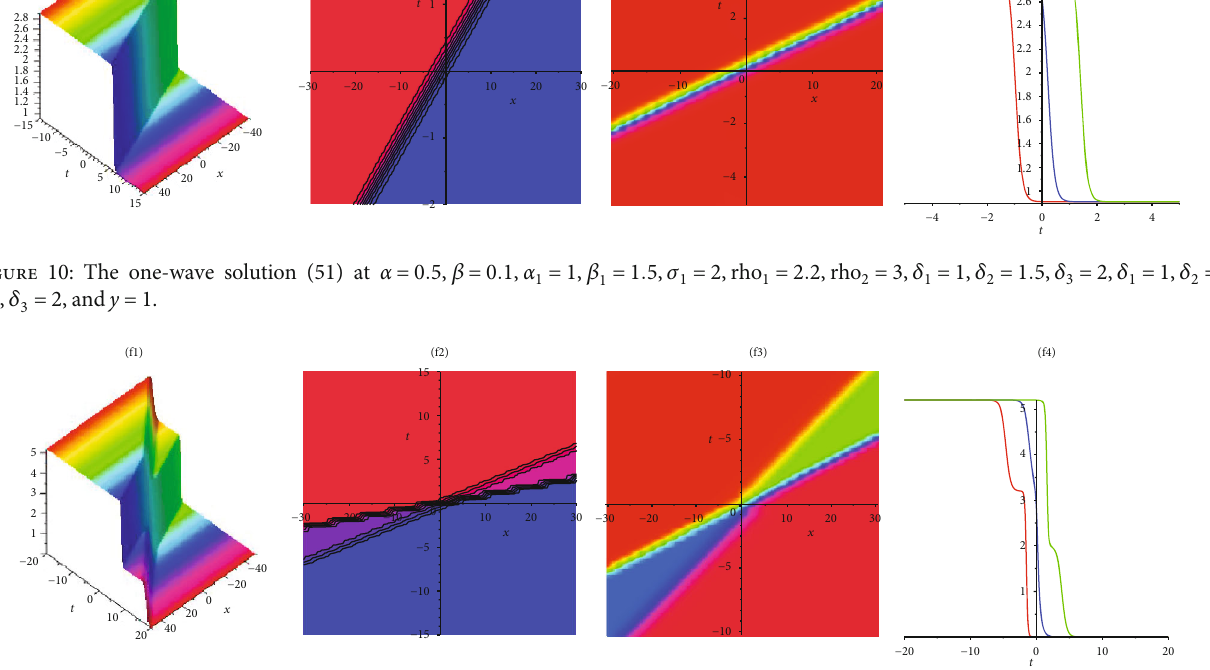
= 1, α = 1 : 6, rho 1 2